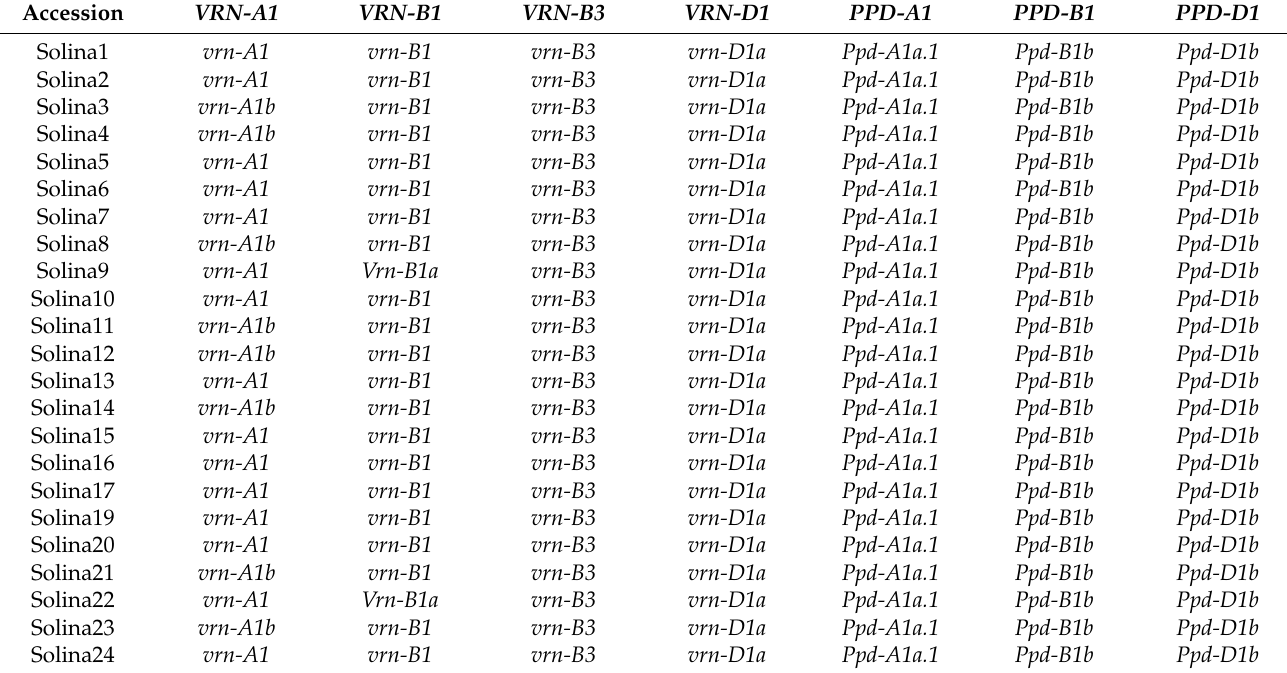
Table 2. Allelic variants of vernalization and photoperiod sensitivity genes identified in Solina